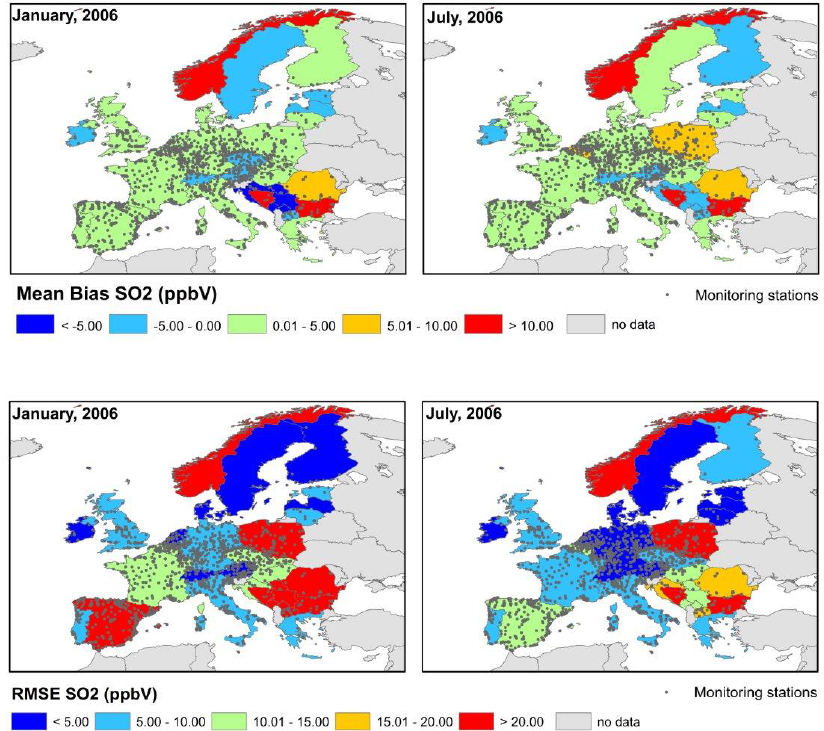
Fig. 6. Mean Bias and RMSE for hourly average SO 2 mixing ratios for the European countries (dots show the distribution of SO 2 monitoring